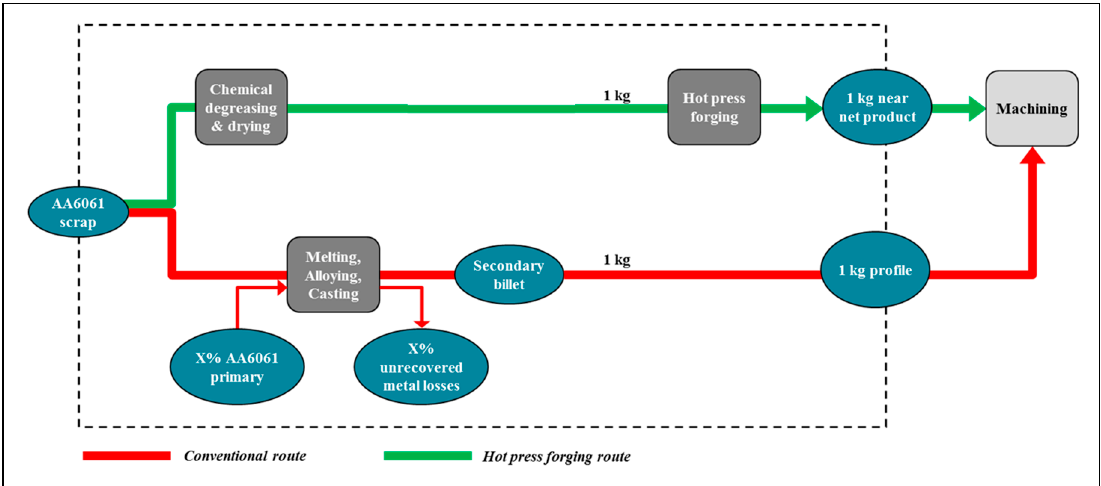
Figure 2. System boundary of the LCA comparison for the different recycling routes.